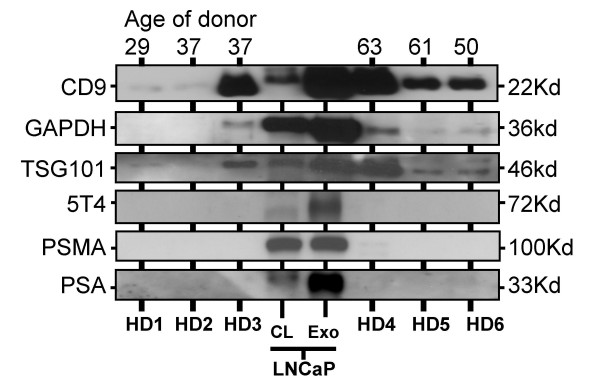
Characterising exosomes from healthy donor urine. Six healthy donors (detailed in Table 3), provided urine specimens and exosomes were purified. Western blots were performed with 5 μg urine-derived exosomes/well, or with 5 μg LNCaP-derived exosomes (Exo) or 5 μg LNCaP whole cell lysates (CL). Blots were probed with antibodies against PSA, TSG101, 5T4, CD9 and GAPDH, as indicated.